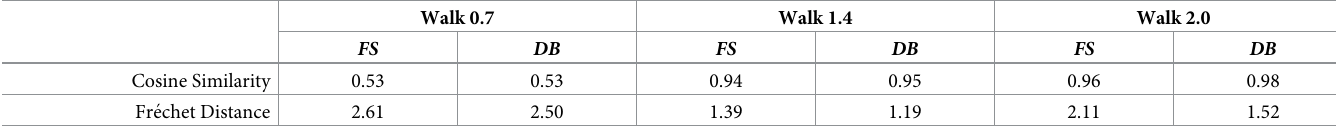
Table 2. Profile shape comparison between the proposed controllers and an EO torque profile based on linearly interpolated HITL optimized parameters from Slade et al. [22]. The cosine similarity represents the overall similarity of profile to the EO profile, values close to 1 are more similar to the EO profile. Fre´chet distance also represents similarity but is a measure of maximum distance, where smaller values are more